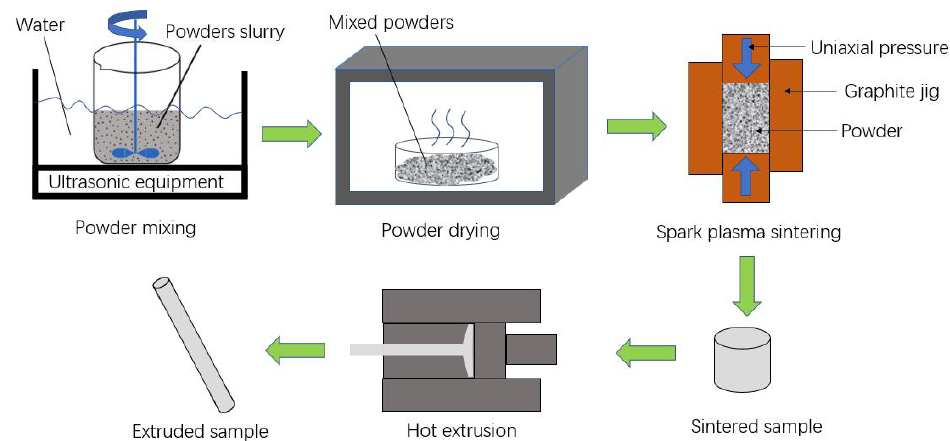
Figure 1. Schematic diagram of TC4/AZ31 composite preparation process. Table 1. Chemical composition of AZ31 alloy (wt.%).